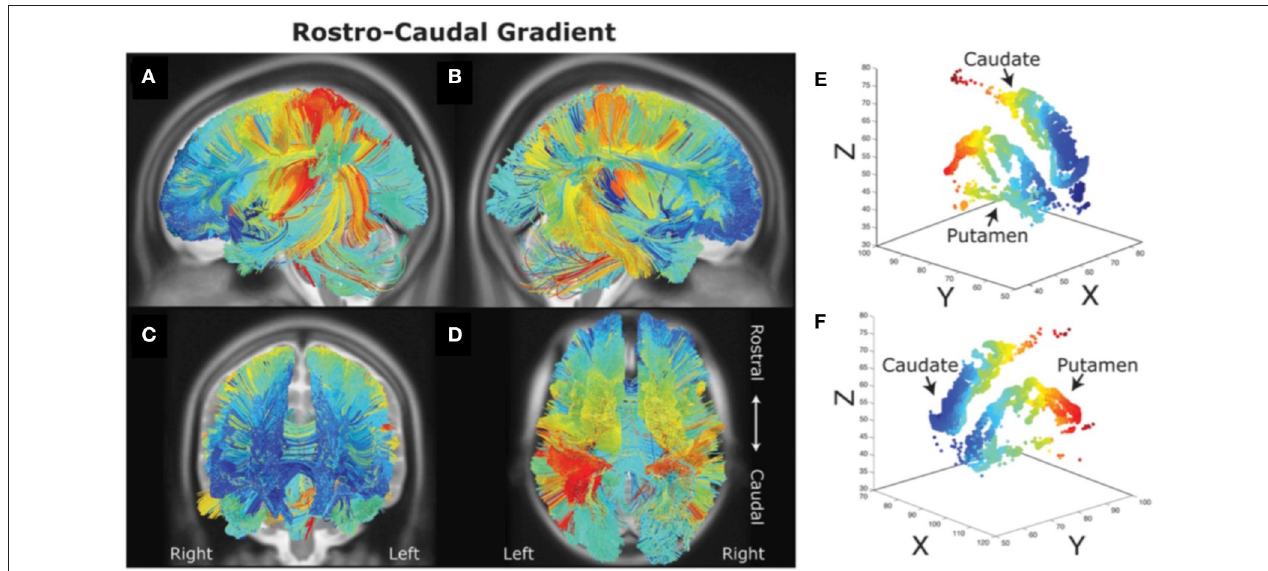
FIGURE 2 | Rostral-caudal gradient of fronto-striatal connectivity (A–F) as measured with diffusion spectrum imaging. It can be observed that rostral (blue) and caudal (red) prefrontal areas are connected with rostral and caudal striatal areas respectively. Figure adapted from Jarbo and Verstynen (2015) with permission from the